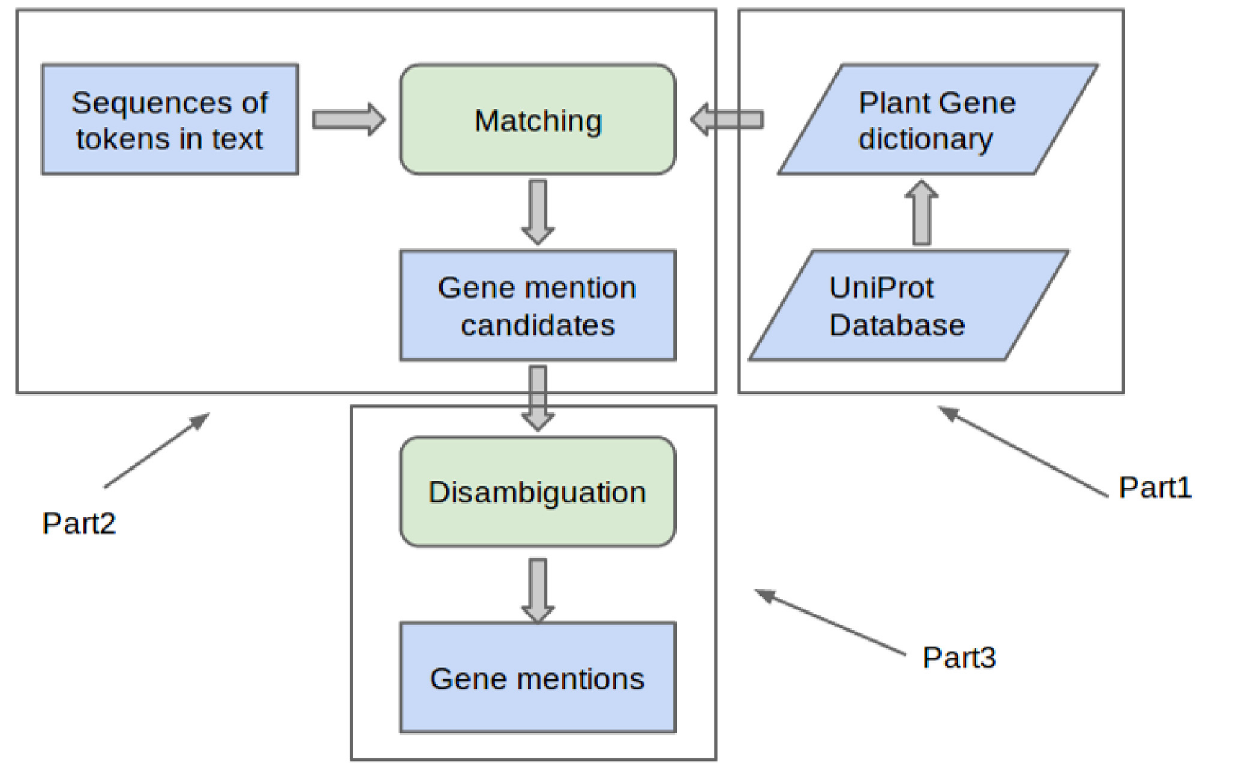
Fig 2. Components of dictionary-based gene mention